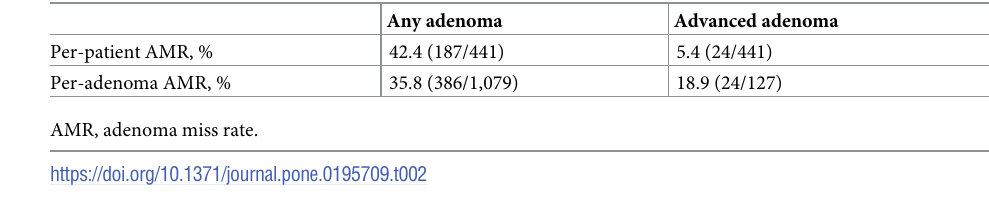
PLOS ONE | https://doi.org/10.1371/journal.pone.0195709 April 26,